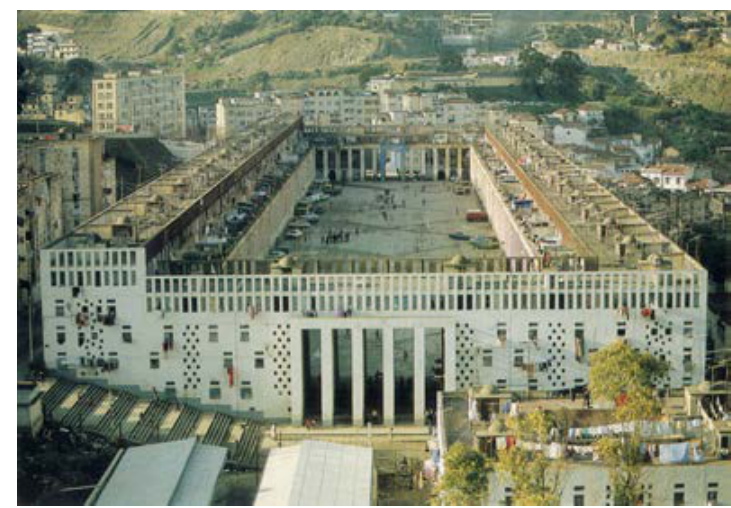
Figure 3. Climatde France housing development